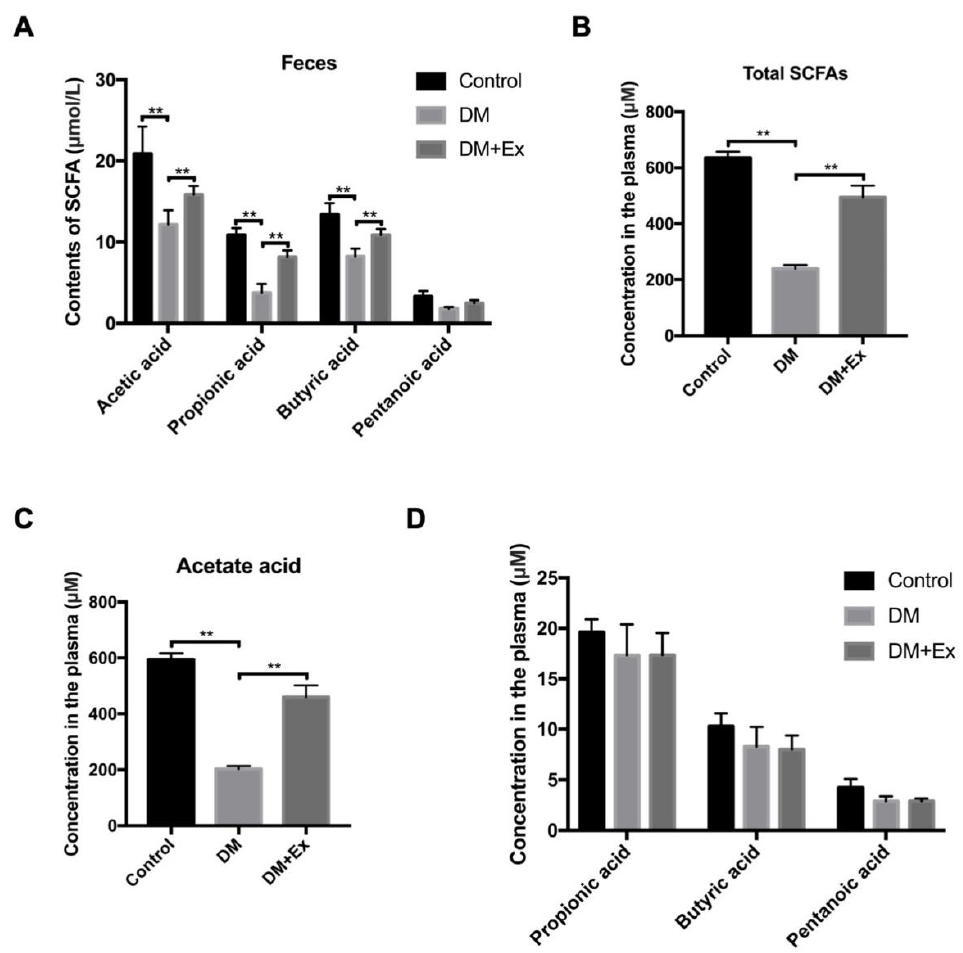
Figure 2. Exercise recovers a DM-mediated reduction of short chain fatty acids (SCFAs). ( A ) Detection of SCFAs in stool of control, DM and DM + Ex groups by gas chromatography (GC); ( B ) detection of total SCFAs concentration in plasma by ELISA; ( C , D ) concentration of acetate acid, propionic acid, butyric acid and pentanoic acid in the plasma of each group detected by GC. ** p < 0.01.